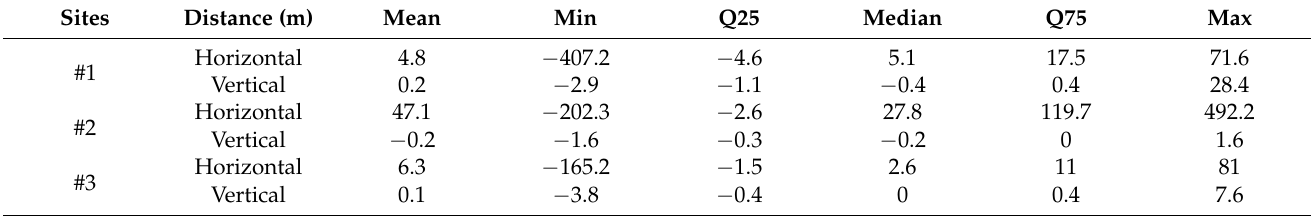
Figure 12. Elevation and position differences between the datum-based tidelines and S2-WL for each Site; ( a , b ) map showing the location of the datum-based tideline (magenta) and S2-WL (blue) for Sites #1 & #2; #3; ( c ) violin plot of position distances; ( d ) violin plot of elevation differences extracted from SurfZone DEM; ( e ) box plots of the differences between the elevations extracted from the DEM along the datum-based tideline and the datum value used (1.64 m for Spurn head and − 1.3 m for Start Bay). Red dashed lines in panels ( c – e ) indicate the representative error ± ε . Elevation and position differences are related to datum-based tideline. Table 3. Mean, Minimum, Maximum, Median and Quantiles 25 and 75 of the horizontal and vertical distances from the datum-based coastlines to the corresponding